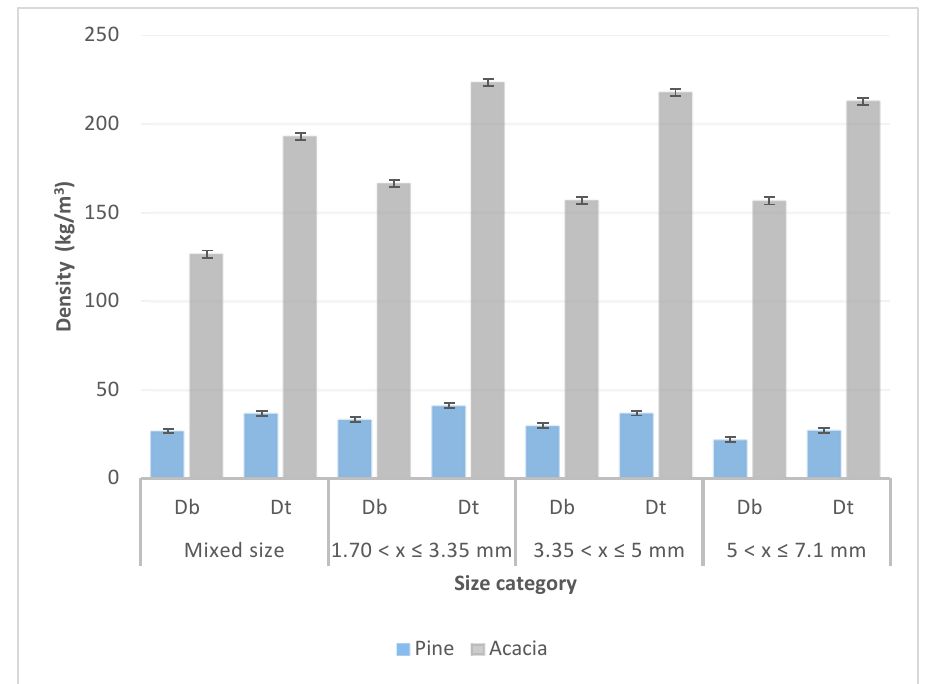
Figure 6. Bulk and tapped densities for various size classes of pine and acacia samples. Db: bulk densities and Dt: trapped densities.